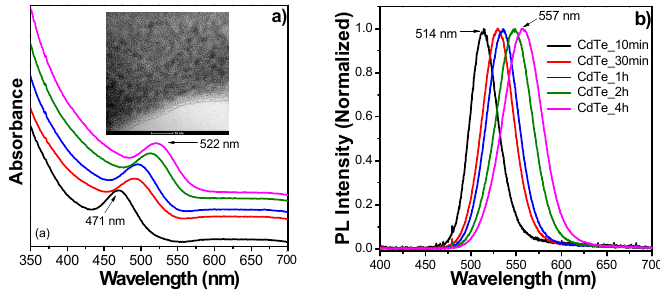
Figure 1. UV–vis absorption ( a ) and photoluminescence (PL) ( b ) spectra of the CdTe nanocrystals stabilized with the ligand 3-mercaptopropionic acid (MPA). Inset in ( a ): TEM image of the CdTe nanocrystals, obtained with 4 h of synthesis, containing 1-dodecanethiol (DDT) as surface